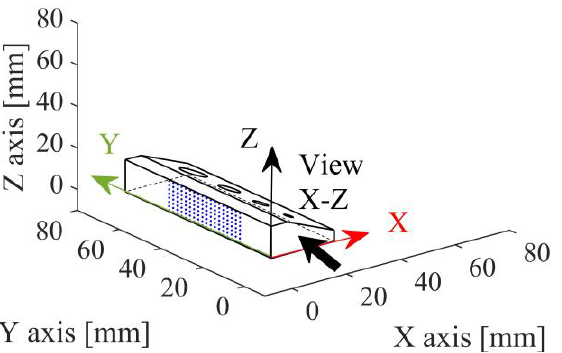
Figure 9. Axonometric view of sample 30° and the pattern of points acquired on the datum plane B.